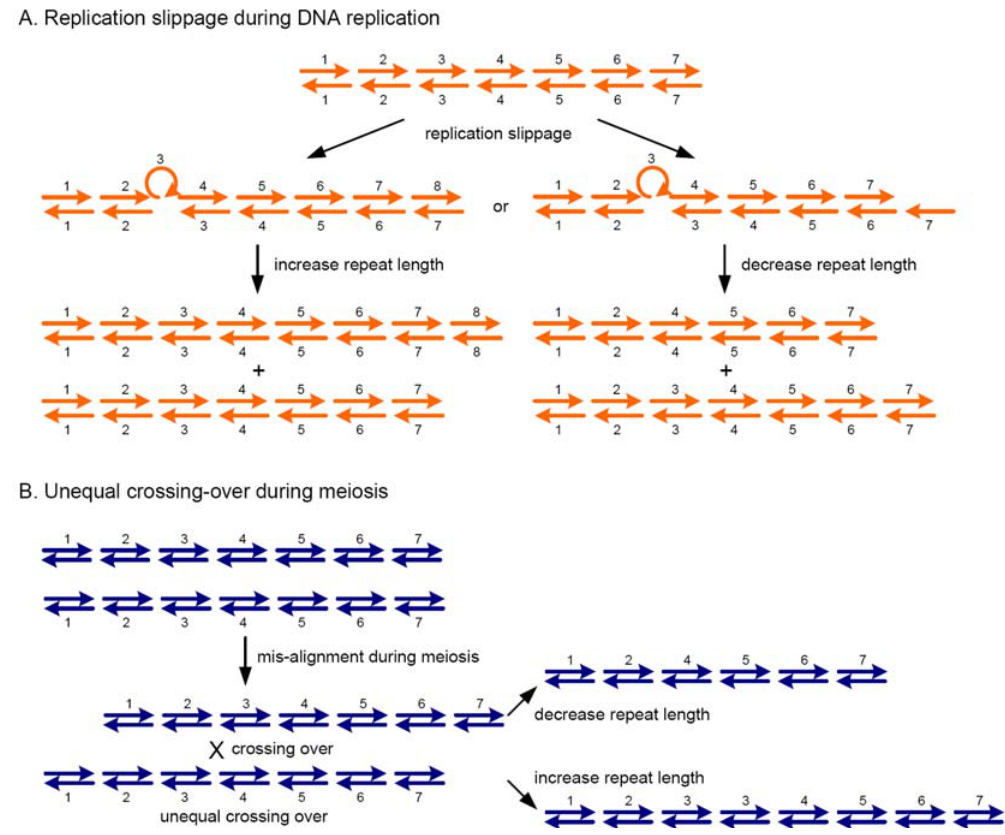
Figure 2. The mechanisms of unequal crossing-over and replication slippage for producing